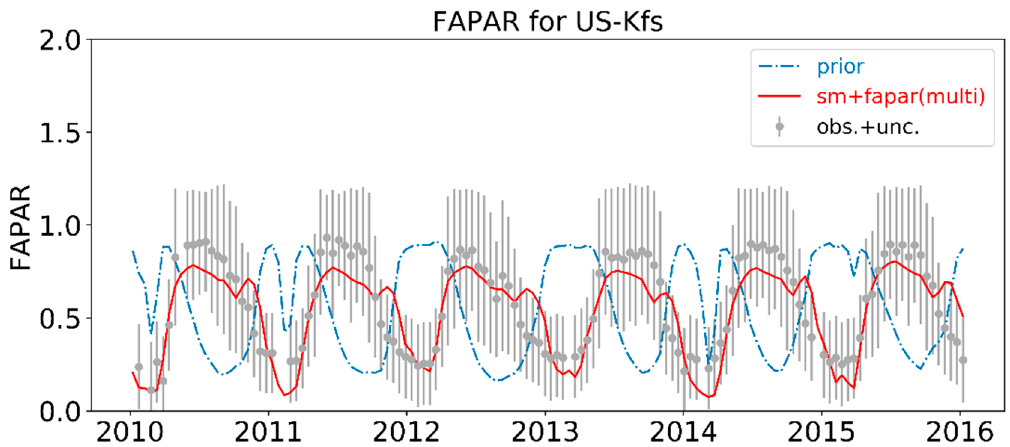
Figure 3. Comparison of simulated FAPAR at site US ‐ Kfs against JRC ‐ TIP FAPAR. The blue dot ‐ dash line denotes the simulation with the prior parameters, the red line denotes multi ‐ site assimilation results with both soil moisture and FAPAR used for assimilation (‘sm+fapar (multi)’), and grey dots error bars denote JRC ‐ TIP FAPAR with uncertainty.